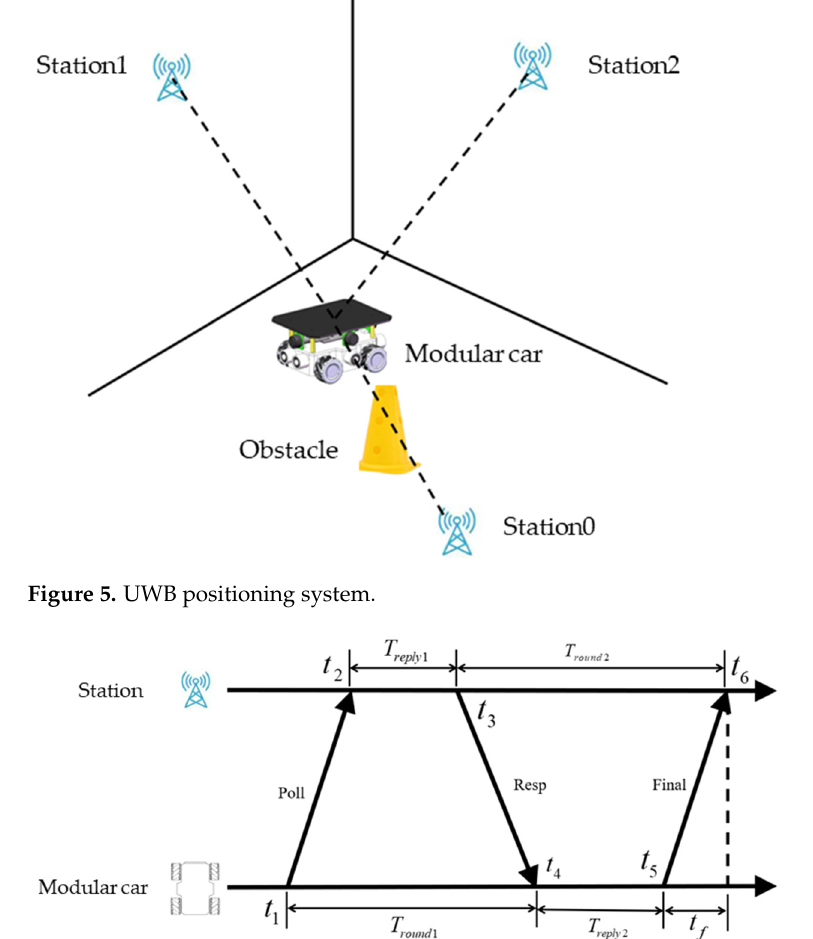
Figure 5. UWB positioning system.